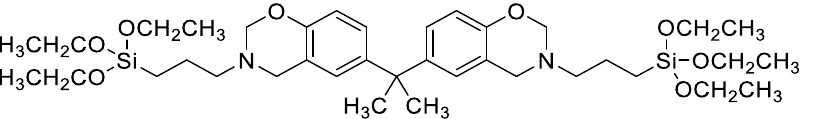
Figure 2. Chemical structure of a novel charring-forming agent (BOZ).